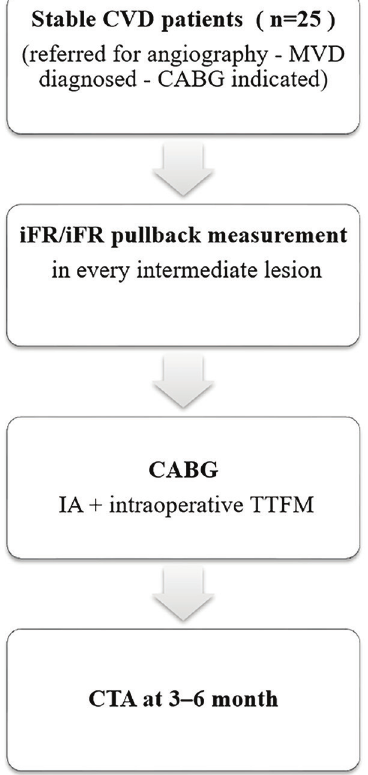
Figure 1 - Flow chart of study design. CVD—coronary vessel disease; MVD—multivessel